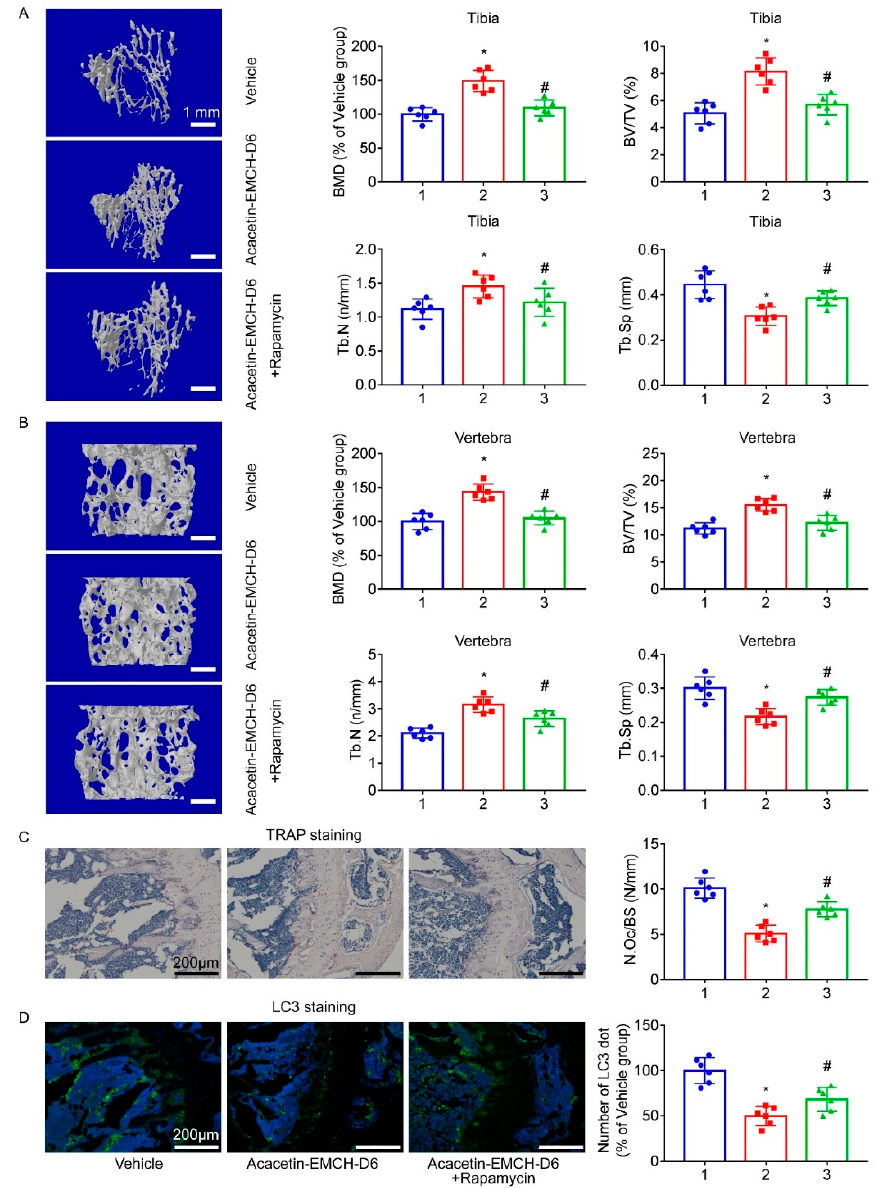
Figure 7. One week after surgery of ovariectomy (OVX), mice were treated with Acacetin-EMCH-D6 (17.5 µ mol/kg/3 days, i.p.) and rapamycin (1 mg/kg/3 days, i.p.) for 5 weeks. Left tibia and L5 vertebrae were subjected to micro-CT scanning. Representative three-dimensional reconstructed images were presented ( A , B ). Trabecular structural parameters of proximal tibia and L5 vertebra